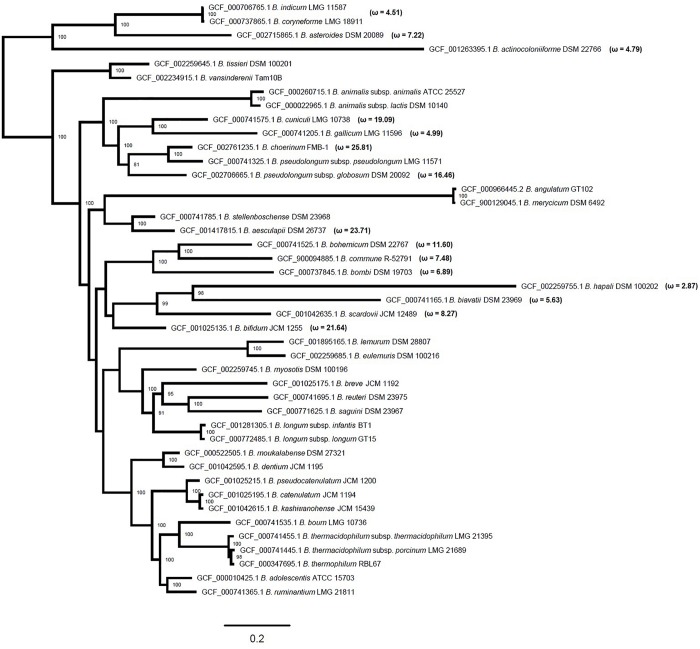
Maximum likelihood phylogenetic tree based on concatenated protein-coding sequences of the pkb2, fn3, aaa-atp, duf58, and tgm genes of 43 representatives of various species of the Bifidobacterium genus after 10,000 bootstrap replicates. Bootstrap values higher than 70 are marked next to the respective nodes showing a robust phylogenetic reconstruction. Values of ω are specified for a class of sites with ω > 1 in those branches of the tree, in which the evidence of episodic positive selection was obtained under strict conditions. The original branch lengths are presented; the scale bar corresponds to the value of two expected substitutions for ten nucleotide sites.